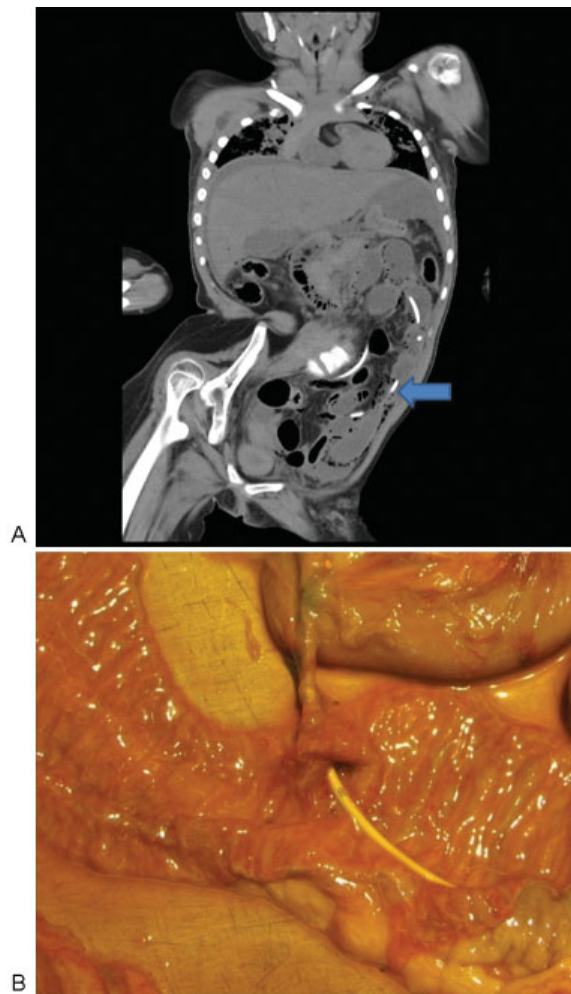
Fig. 3 A 10-year-old girl with spina bi fi da aperta. The hydrocephalus was corrected with a ventriculoperitoneal shunt (VPS). The girl died after the shunt had migrated into the jejunum and had caused bowel ischemia, perforation, and peritonitis. The postmortem computed tomography (A) and the autopsy image (B) show the VPS in intra- luminal jejunal